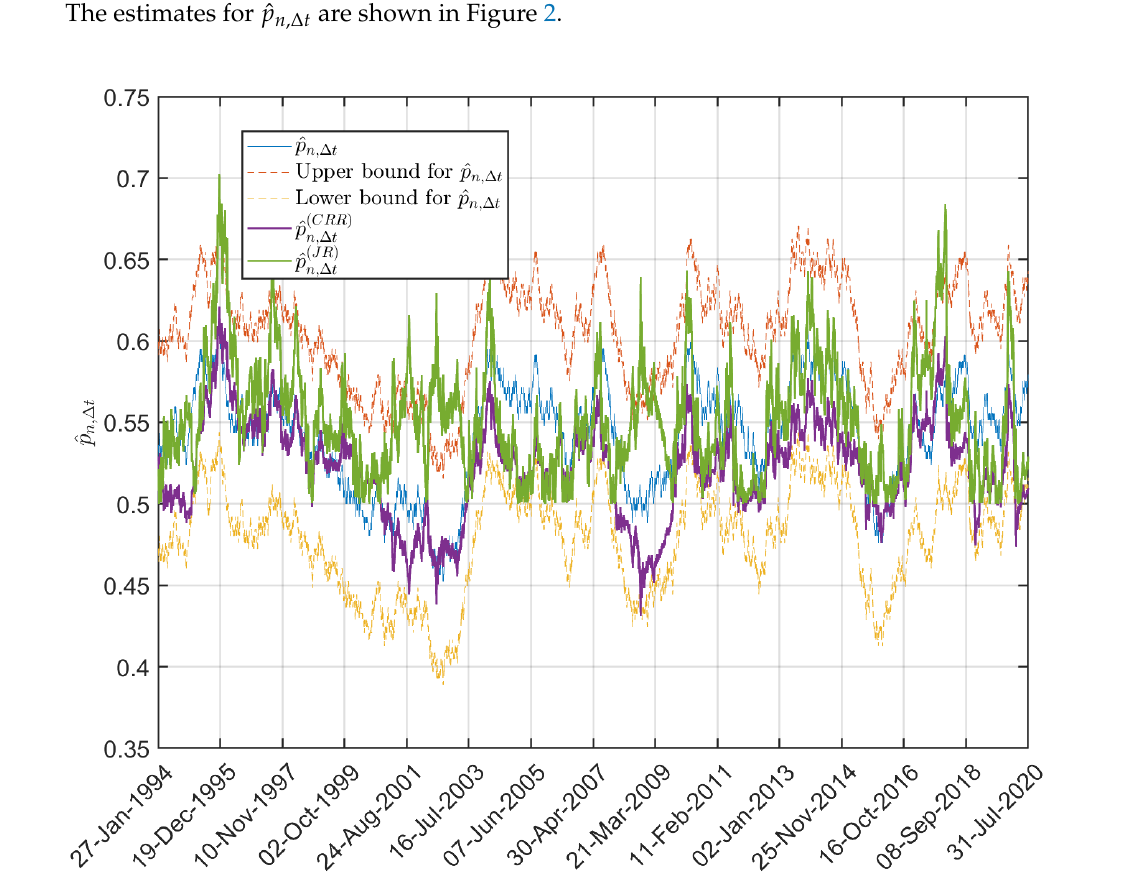
Figure 2. Values of ˆ p n ∆ t of the SPY daily log-returns computed from a one-year moving window over the time period 27 January 1994 to 31 July 2020. Additionally displayed are values for ˆ p computed as described in Section